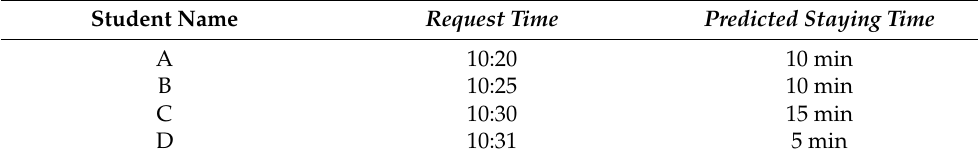
Table 1. The situation where 4 people intend to enter a canteen which can only contain 1 person. Student Name Request Time Predicted Staying